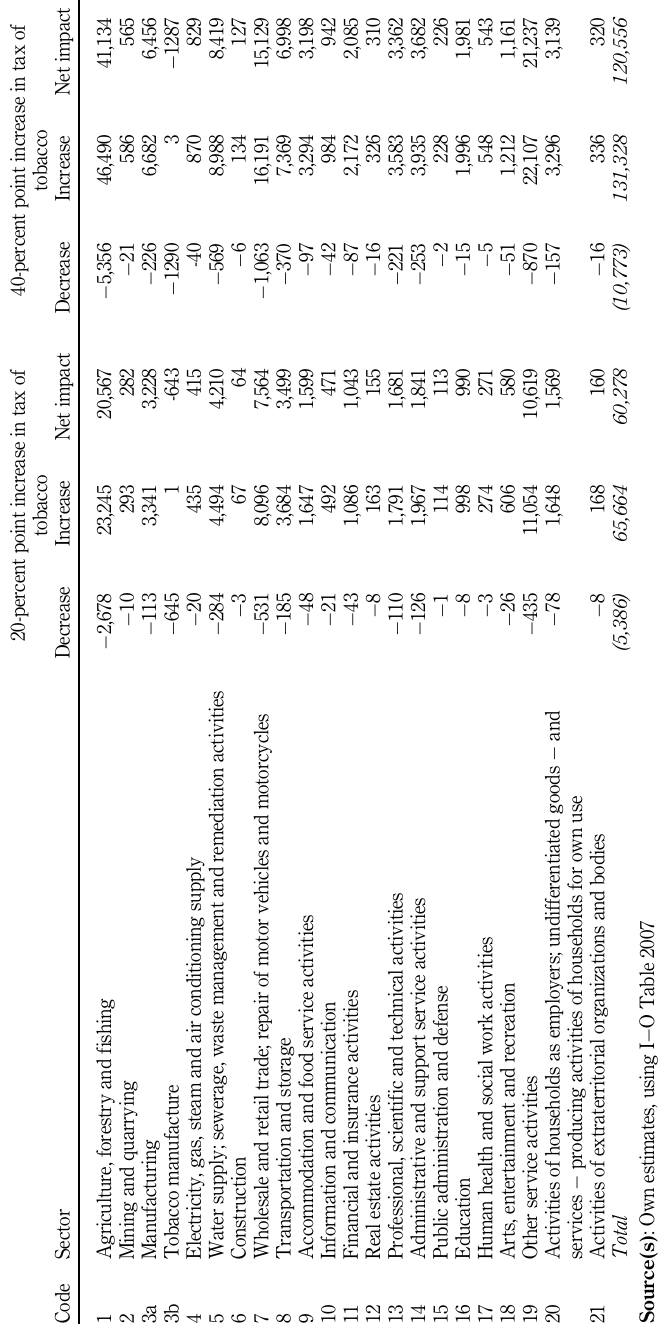
on national employment